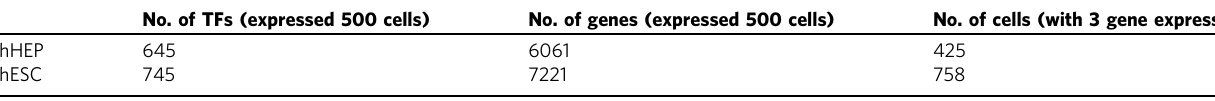
Table 3 Statistics for the scRNA-Seq data for hHEP and hSCE.